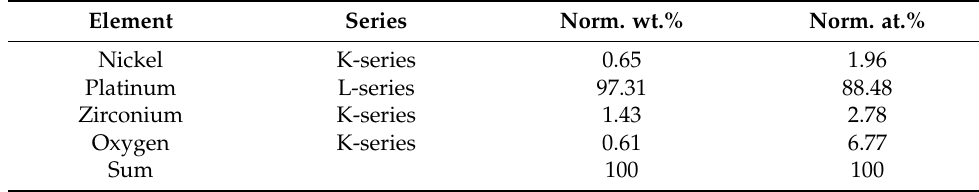
Table 2. Chemical composition of Pt agglomerate from Figure 8a (sample 4 ). Element series Element Series Norm.